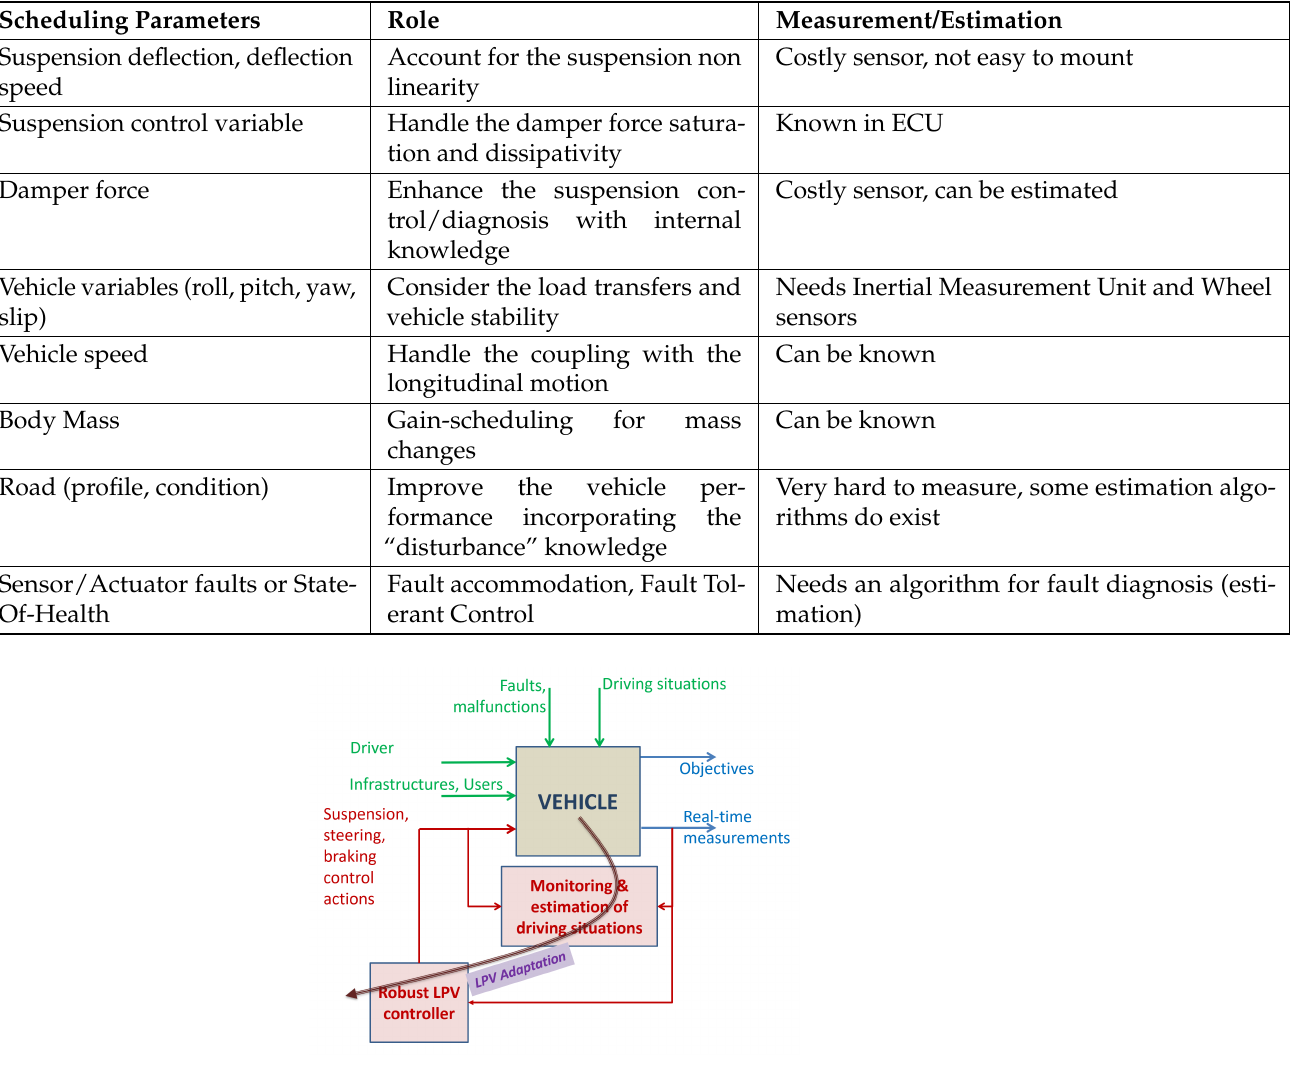
Figure 12. LPV generic control